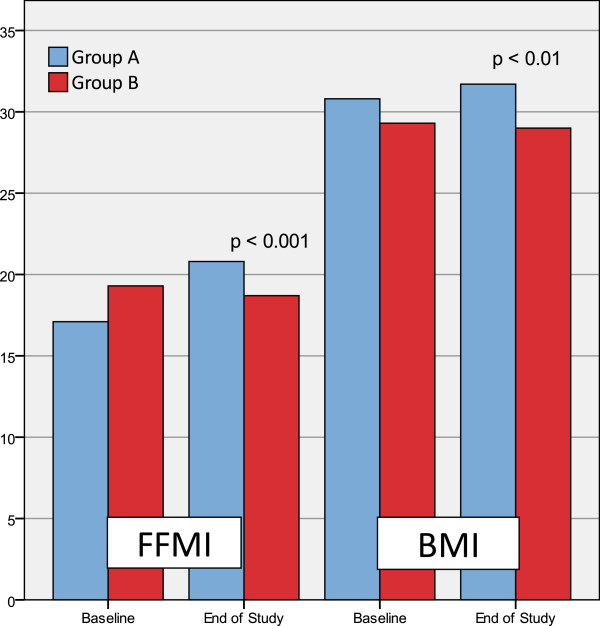
End of study comparison between the two groups of the Fat Free Mass Index (FFMI) and Body Mass Index (BMI). After two months of therapy FFMI (p < 0.001) and BMI (p < 0.01) were higher in patients treated with dietary supplementation (group A).